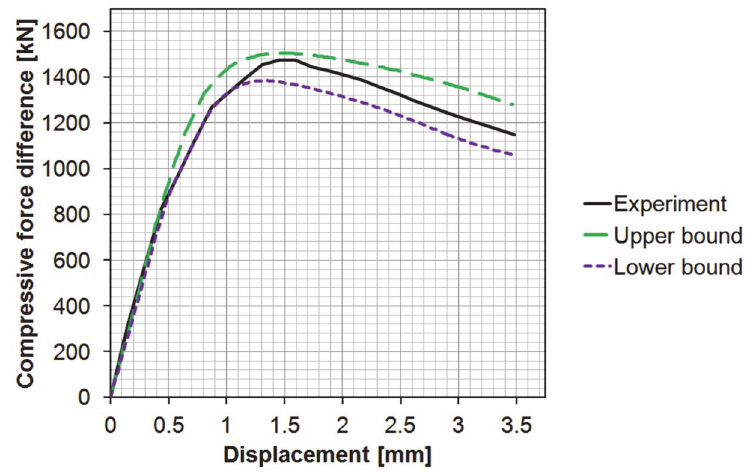
Figure 3: The boundary load-displacement